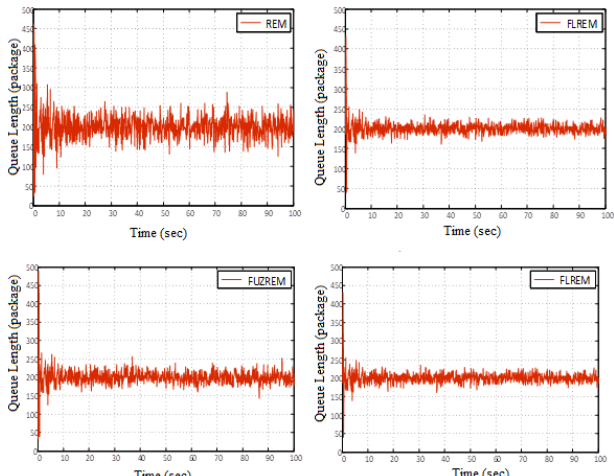
Figure 13. Control the queue of REM, FUZREM and FLREM